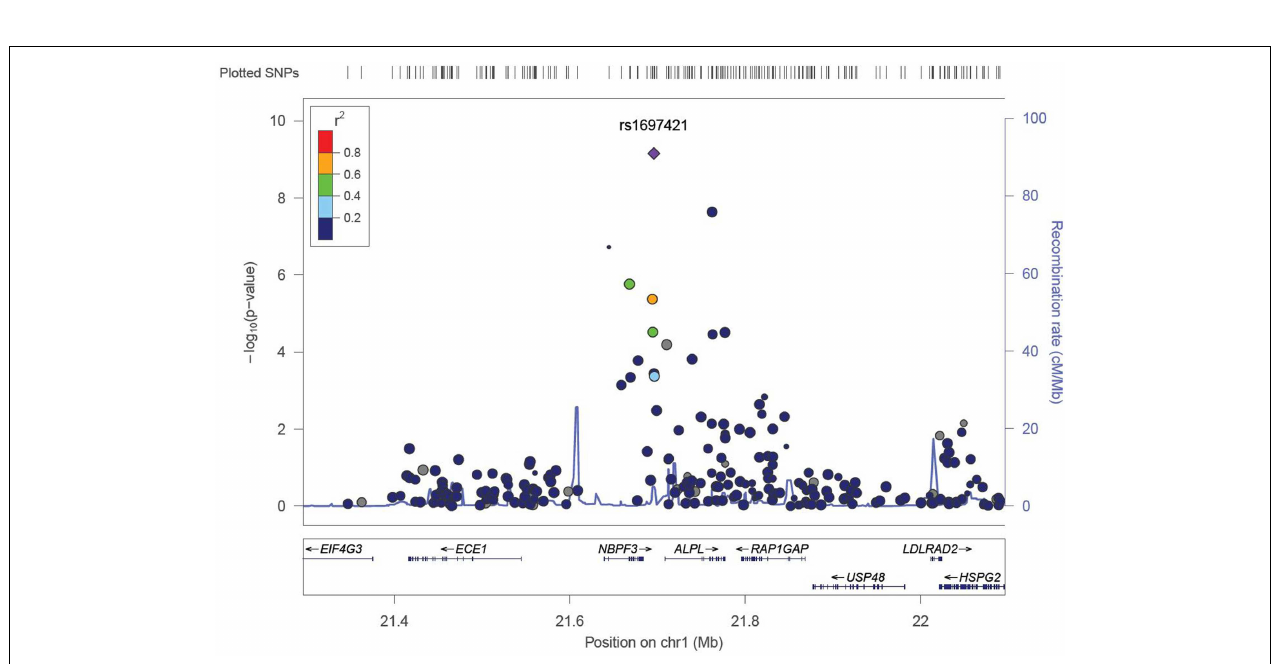
2. Interestingly, genetic variations at this locus have been associ- ated with depression (32) and schizophrenia (33–35). This locus mayhelpexplaintherecentdatapositivelycorrelatingserumfolate levels with cognitive test scores in children (36); suggesting further evaluationof theeffectsof folate